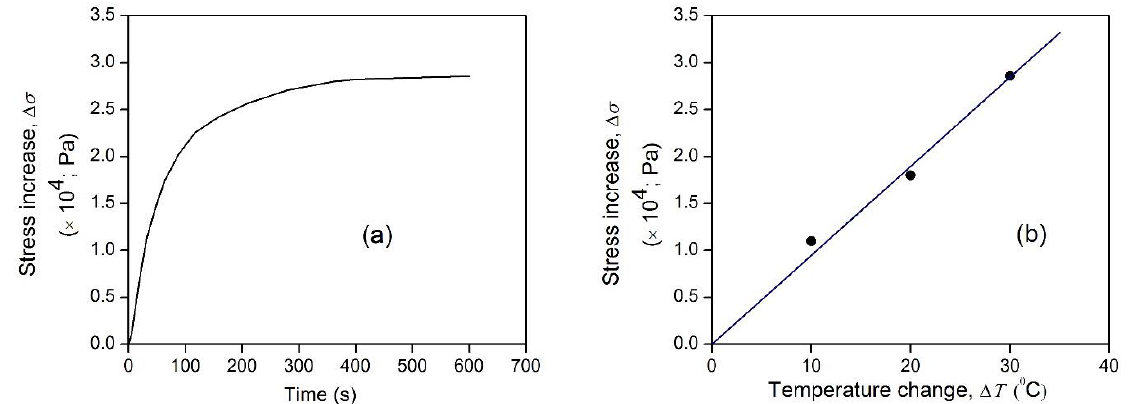
Figure 3. ( a ) Stress increase ∆ σ in the bandage upon activation under constraint deformation ( ε = 30%; T = 50 ˝ C). ( b ) Results of stress increase ∆ σ with increase in temperature ∆ T (Equation (4)).